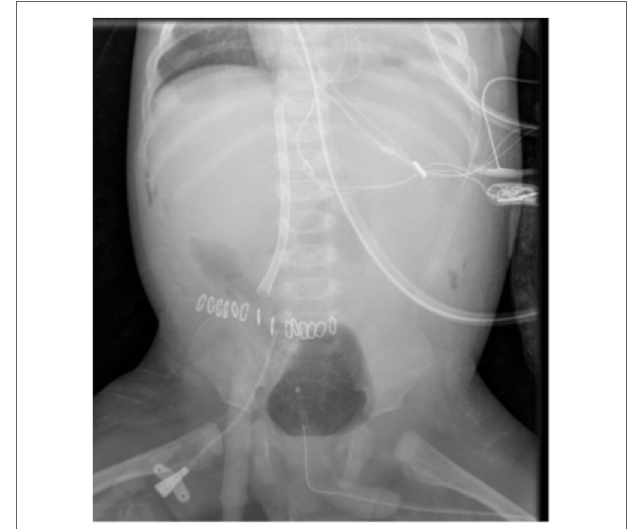
FigURe 2 | IVC access via extra-peritoneal